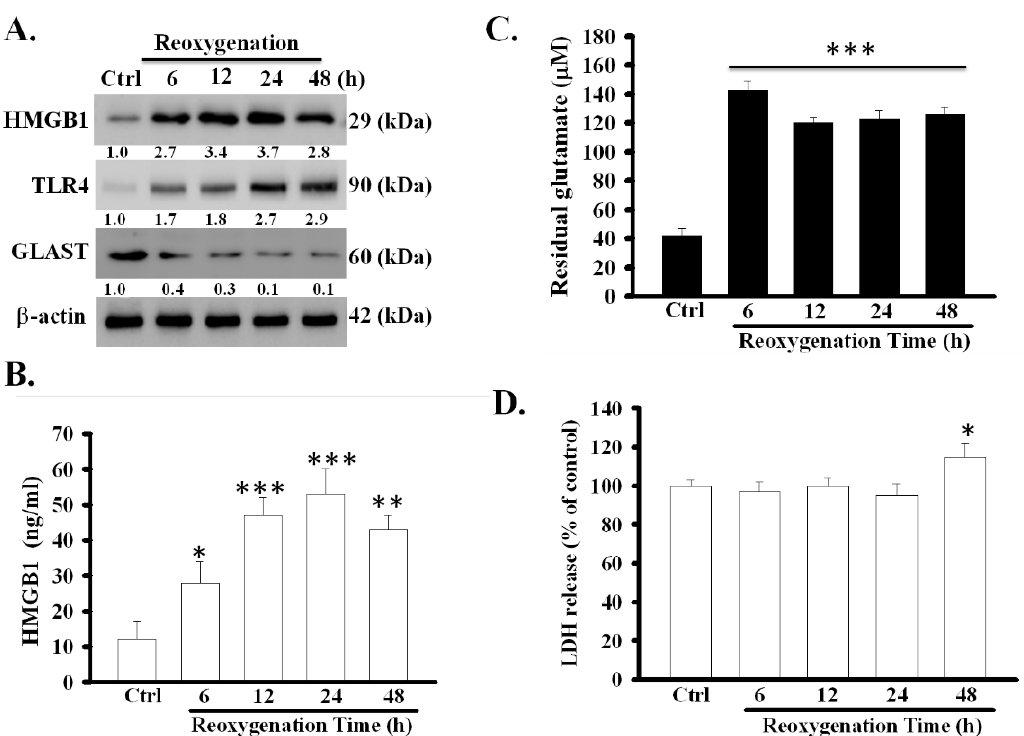
Figure 1. Effects of OGD/R on the expression of HMGB1 and TLR4 and the function of glutamate clearance in primary astrocytes. Primary astrocytes were exposed to OGD for 6 h followed by returning the cells to the normal cell culture condition (reoxygenation for 6–48 h). Thereafter, the expression of HMGB1, TLR4 and GLAST protein ( A ) were examined using Western blot. HMGB1 secretion ( B ) was analyzed using ELISA. The activity of glutamate clearance ( C ) was measured at each indicated time points after reoxygenation. Cell damage was assayed by measuring LDH release ( D ) * p < 0.05, ** p < 0.01, *** p < 0.001 vs. control group (ctrl). Data are presented as mean ± SEM, n = 6–8. OGD / R, oxygen-glucose deprivation / reoxygenation; HMGB1, high-mobility group box 1; TLR4, toll-like receptor 4; GLAST, glutamate aspartate transporter; LDH, lactate dehydrogenase; n , number of repeated examinations. The protein levels of HMGB1, TLR4 and GLAST were quantified by densitometric scanning of Western blots and normalized to β -actin in graph of Figure